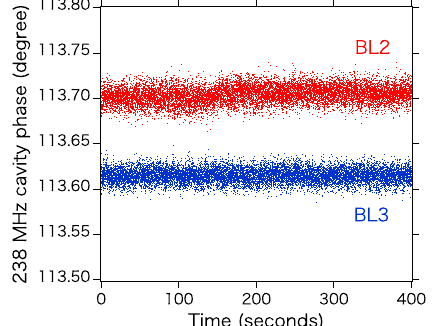
FIG. 10. RF phase of a 238 MHz cavity. The phases of 60 Hz RF pulses are alternately changed between the optimum values of BL2 (red dots) and BL3 (blue dots).